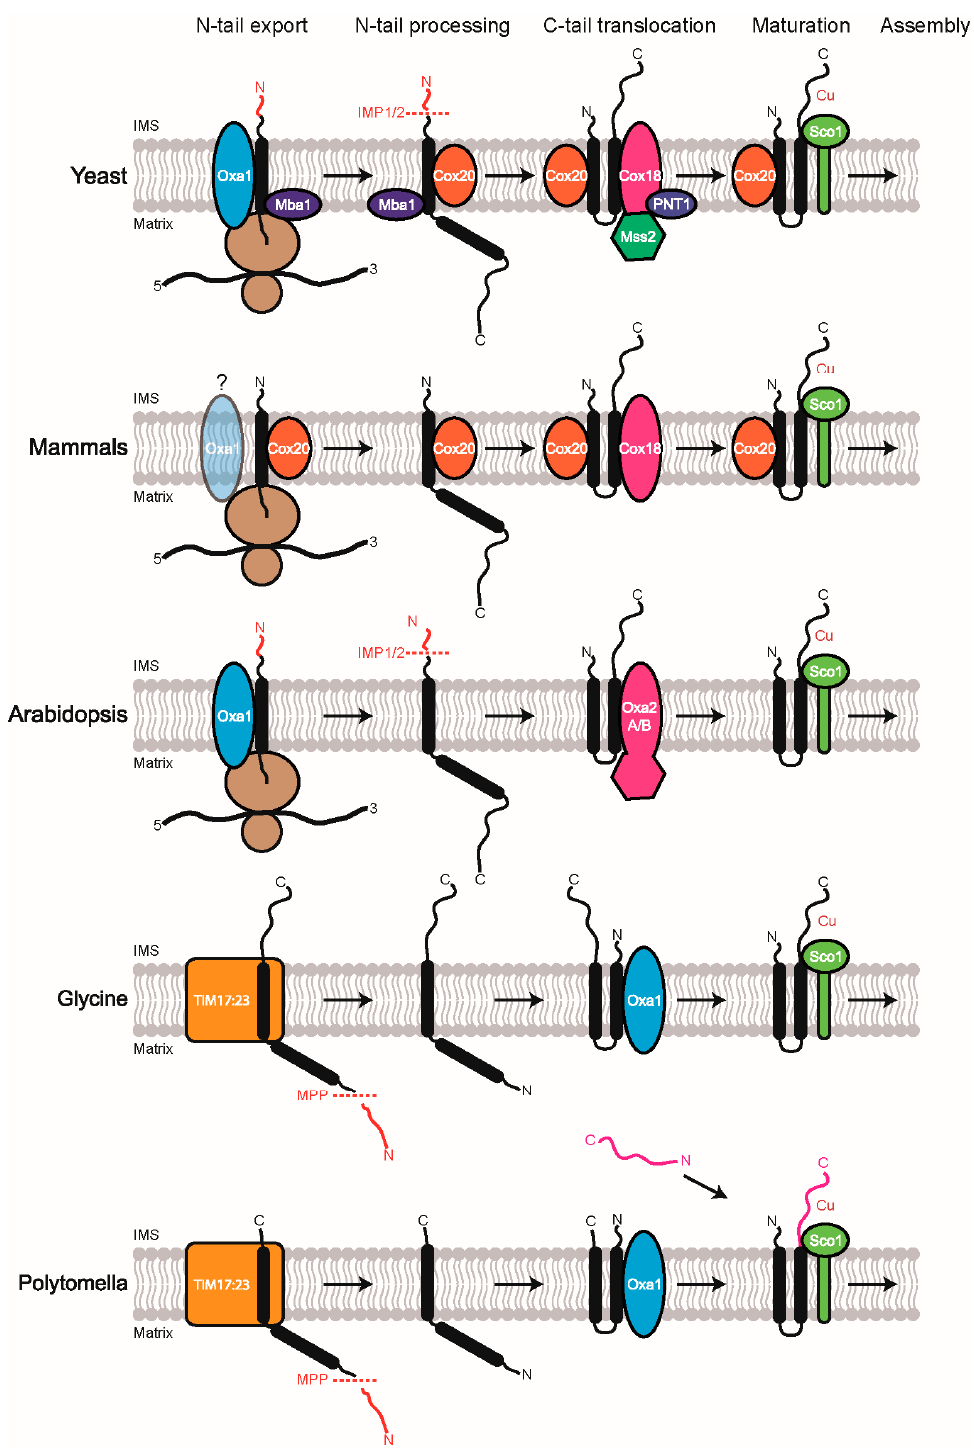
Figure 3. Cox2 biogenesis in yeast, mammals, Arabidopsis , Glycine , and Polytomella . Our current understanding of how Cox2 is inserted into the MIM of yeast ( Saccharomyces cerevisiae ) and mammals ( Homo sapiens ) is as depicted. The four steps of Cox2 assembly are N-tail export with TMH1 membrane insertion, N-tail processing, C-tail translocation with TMH2 membrane insertion and maturation by copper insertion. The last arrow represents the assembly step into complex IV. Based on this knowledge and some limited available studies with plant mitochondria, we have hypothesized the Cox2 insertion pathways for two plant species, Arabidopsis thaliana , Glycine max , and an algal species, Polytomella sp. In yeast, mammals, and Arabidopsis , Cox2 is synthesized by the mitochondrial ribosome whereas in Glycine and Polytomella , it is cytosolically synthesized and imported into the mitochondria. For full details, see the corresponding sections in the text.